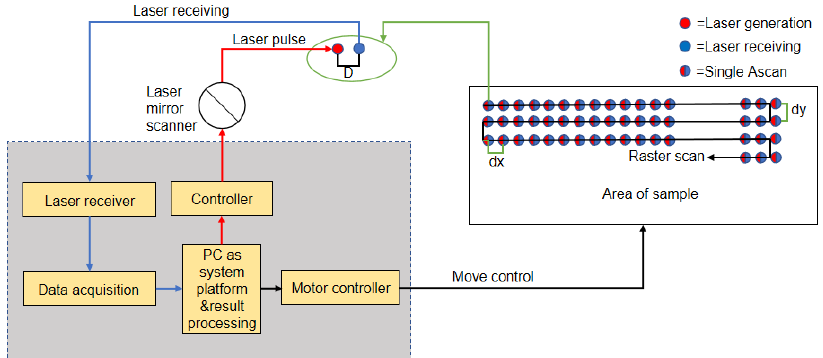
Figure 3. LGU system and scanning imaging strategy.